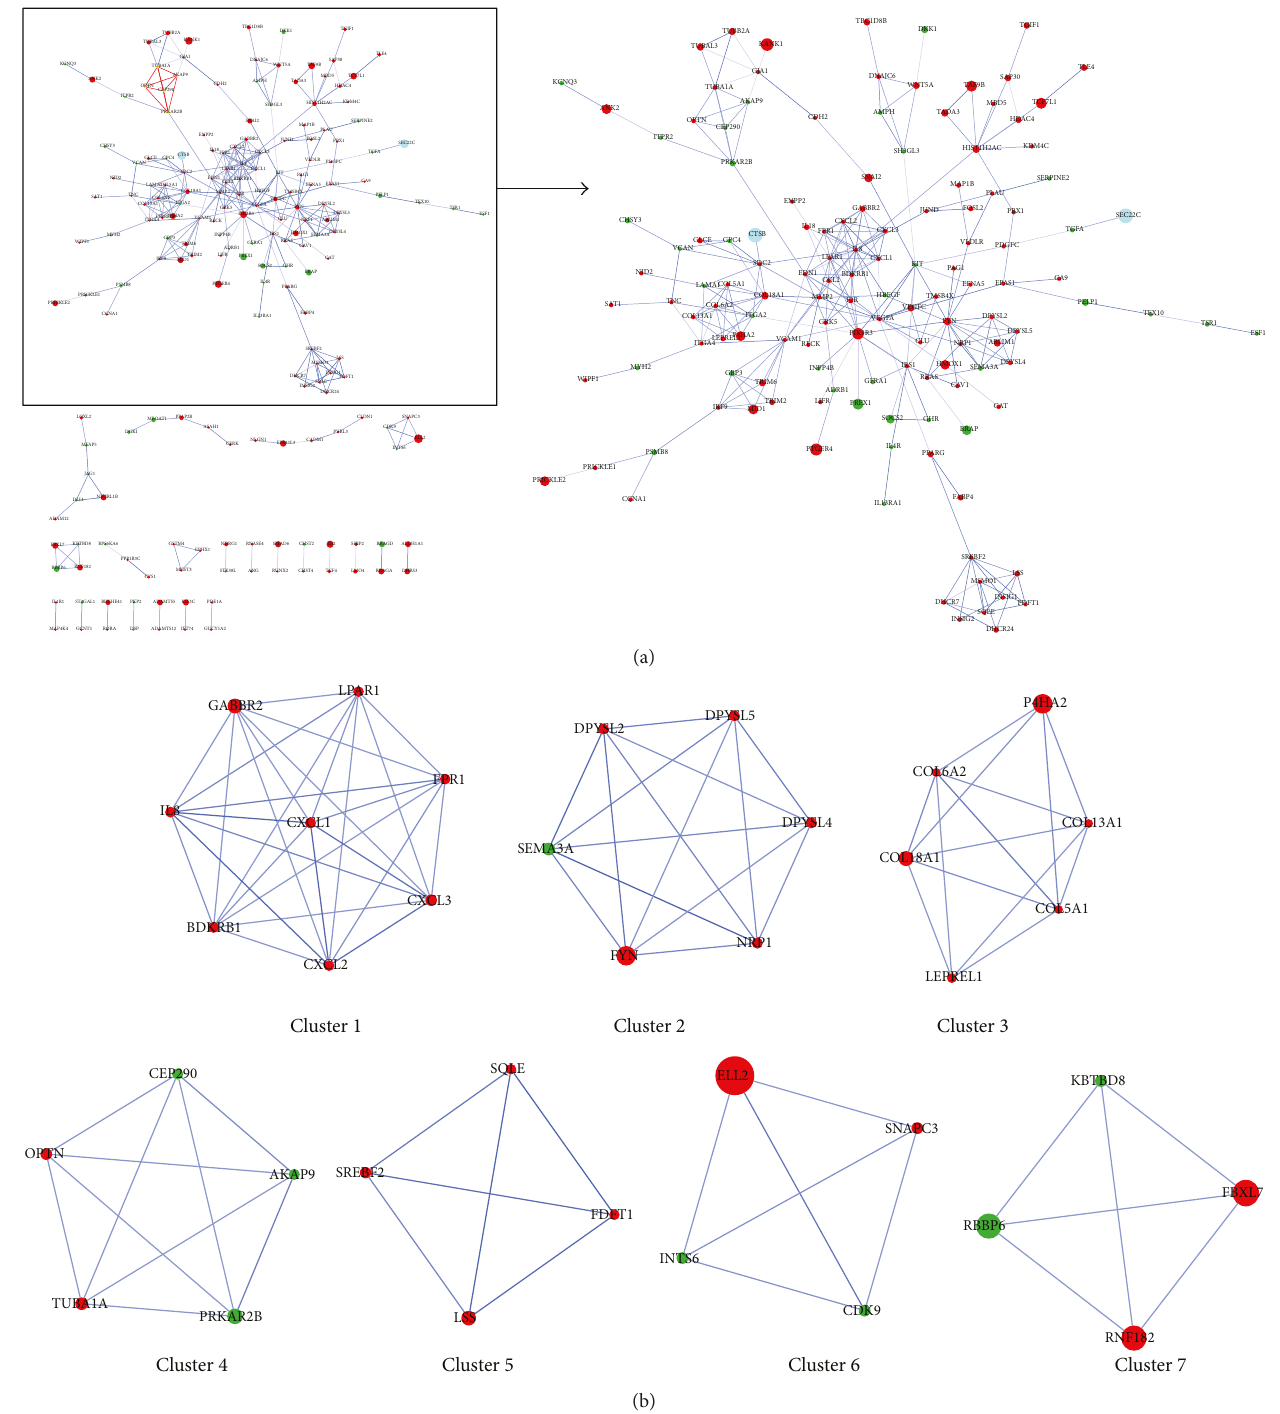
Figure 5: PPI network constructed by Cytoscape and top seven module networks by MCODE. (a) The PPI network was constructed dependent on the STRING online database (available online: http://string-db.org) and Cytoscape software (version 3.4.0, available online: http://www.cytoscape.org/). (b) The top seven module networks with a score no less than 4 were analyzed by MCODE. The red nodes stand for upregulated genes, and the green nodes stand for downregulated genes. The larger the node diameter is, the smaller the P value and the more signi fi cant the node is. PPI: protein – protein interaction; MCODE: Molecular Complex Detection; STRING: Search Tool for the Retrieval of Interacting